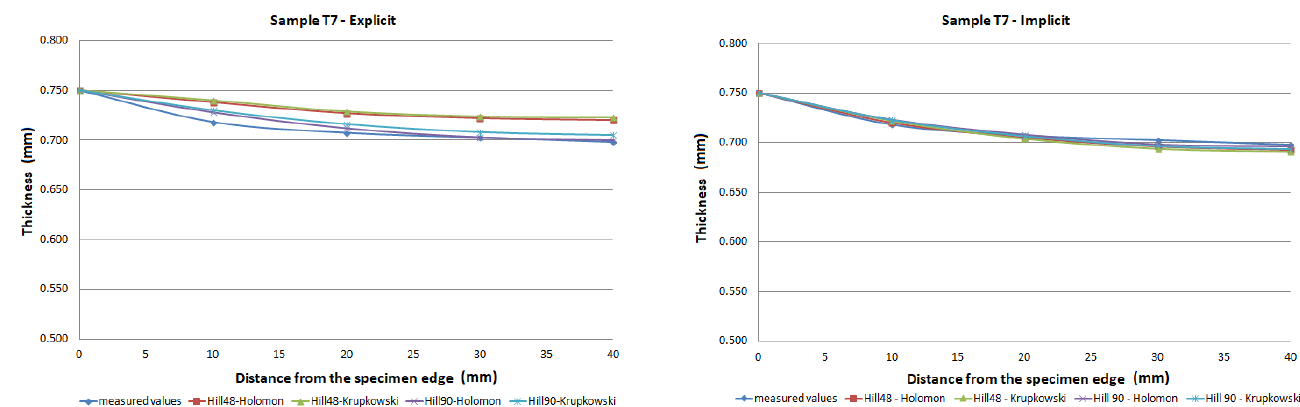
Figure 19. Comparison of predicted and measured thickness values of sample T8 using various yield criteria, hardening laws, and integration scheme. The predicted thickness of the formed part showed the best correlation with meas- ured thickness values when the Hill90 yield surface model combined with the Hollomon hardening model was used in simulation software with the explicit solver. The combina- tion of the Hill90 yield surface model and Krupkowski hardening model showed the best correlation of thickness results when simulation software using implicit solver was used. Overall, smaller deviations of predicted thickness were observed for samples with lower deformation, lower dome height (samples T7, T8) and higher deviations of thickness were observed in samples with greater deformation, higher dome height (samples T3, T4). The results obtained using software with implicit solver showed a better correlation with ex- perimental thickness results than results obtained using the software with explicit solver. Mean deviations of predicted thickness t from the measured thickness values are shown in Tables 5 and 6. Mean deviations were calculated according to the formula: 𝐷𝑒𝑣 𝑋 = 𝑋 𝑠𝑖𝑚 − 𝑋 𝑒𝑥𝑝 𝑋 𝑒𝑥𝑝